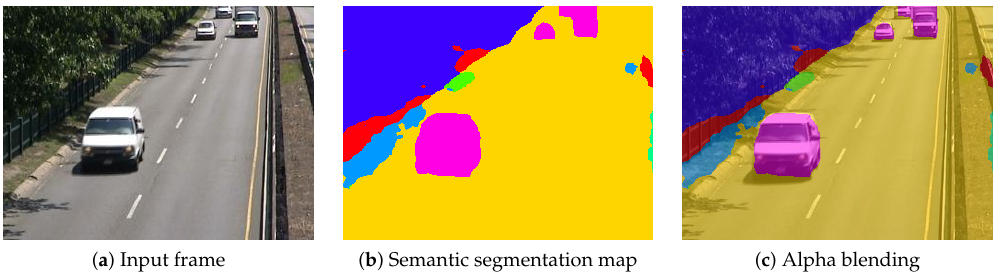
Figure 2. Example of a frame ( a ) along with its semantic segmentation map ( b ) returned by the PSPNet algorithm [9] (see Section 4.1) and an alpha blending of both ( c ). The labels are: road (cid:4) , grass (cid:4) , sidewalk (cid:4) , earth (cid:4) , plant (cid:4) , car (cid:4) and fence (cid:4)